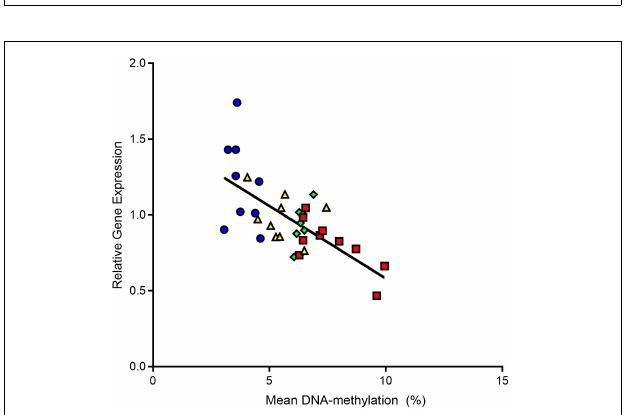
FIGURE 4 | Mean DNA-methylation in the Y2 receptor gene promoter of male animals. Significant results of post hoc test (SNK) are represented as * p ≤ 0.05. CON, control; ELS, early life stress; CON+AS, control + adult stress; ELS+AS, early life stress + adult stress.